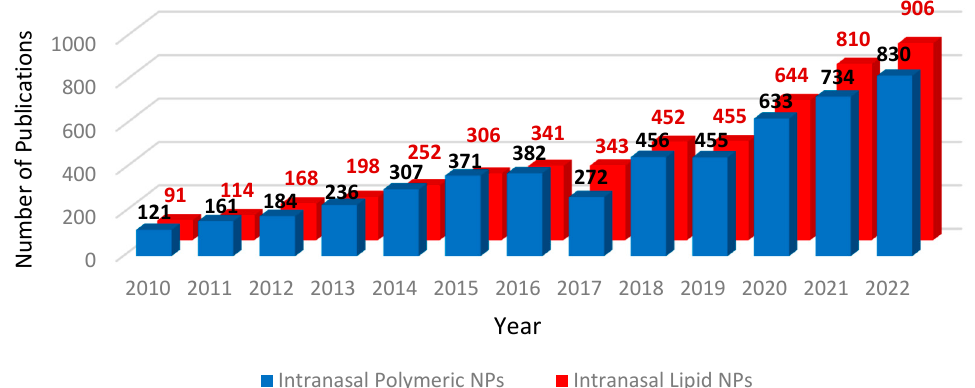
Figure 2. Advances in intranasal polymeric and lipid-based nanocarriers in the past decade. Searches were carried out in the Scopus database using search terms “intranasal” and “polymer” and “nanoparticle” or “intranasal” and “lipid” and “nanoparticle”.